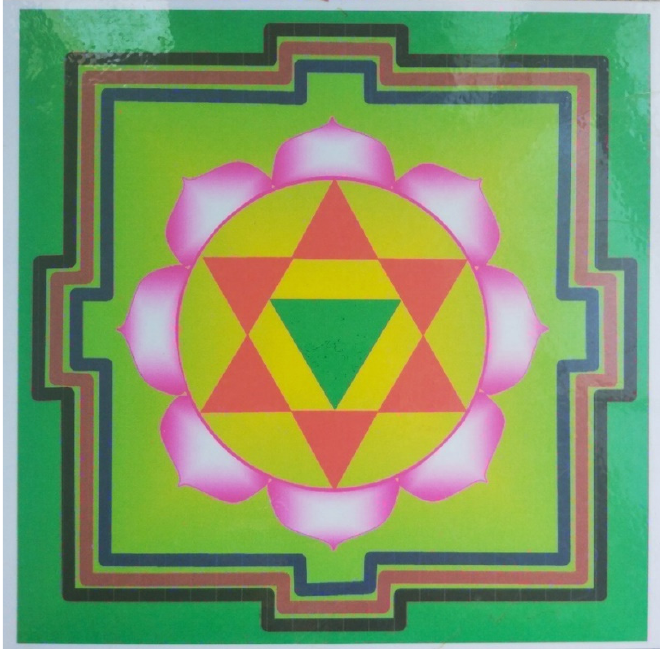
Figure 3. Ga ṇ apati yantra . Credit: based on material provided in Ś aktipur.